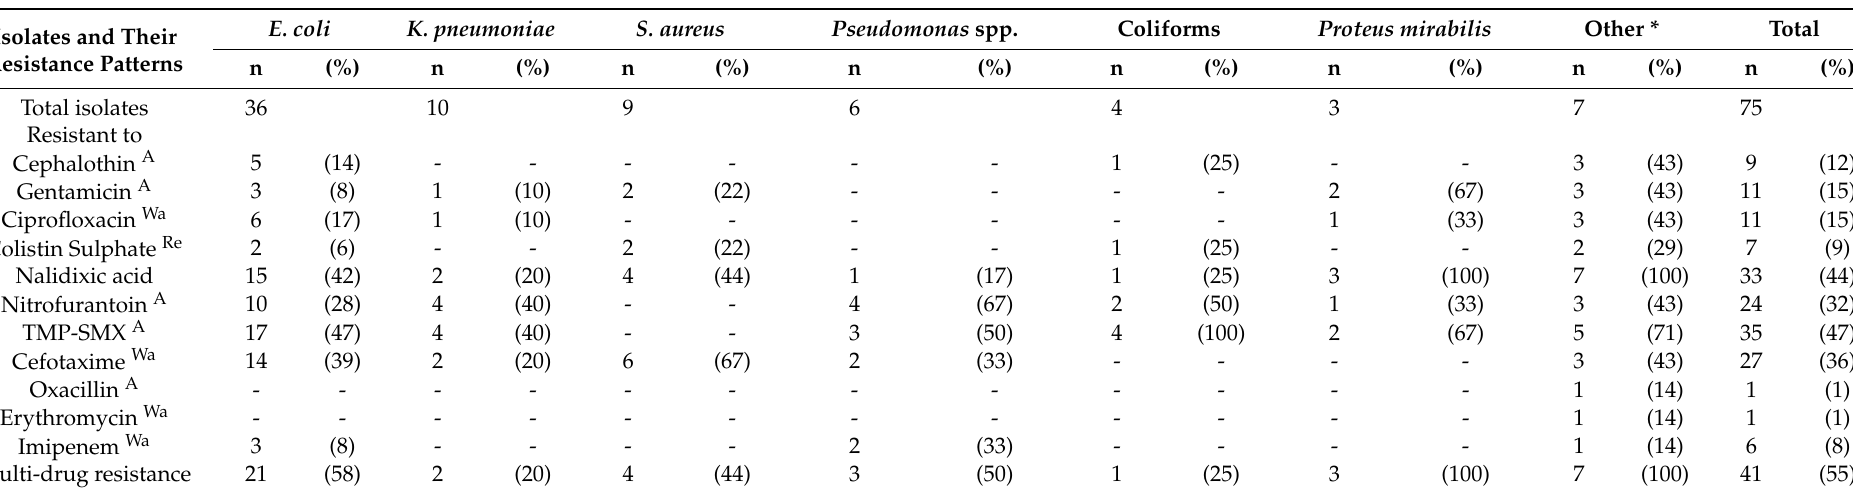
Table 1. Bacterial isolates and their antimicrobial resistance patterns in culture-positive urine samples in two hospitals in Freetown, Sierra Leone, between May 2017 and May 2021 [N =